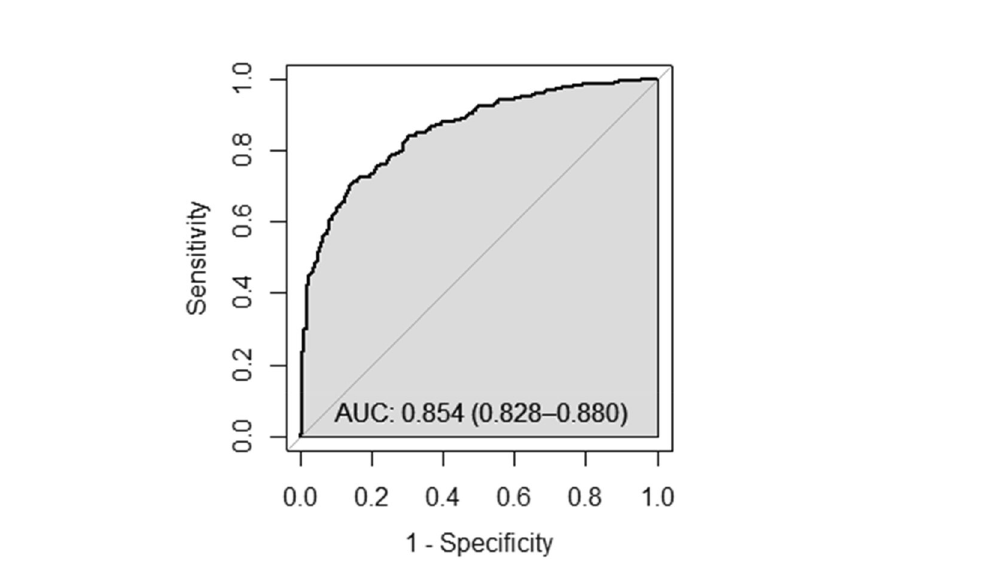
Figure 2. Receiver operating characteristic analysis for the accuracy of APRI to diagnose cirrhosis (transient elastography ≥ 12.5 kPa) in patients with hepatitis C infection (n =